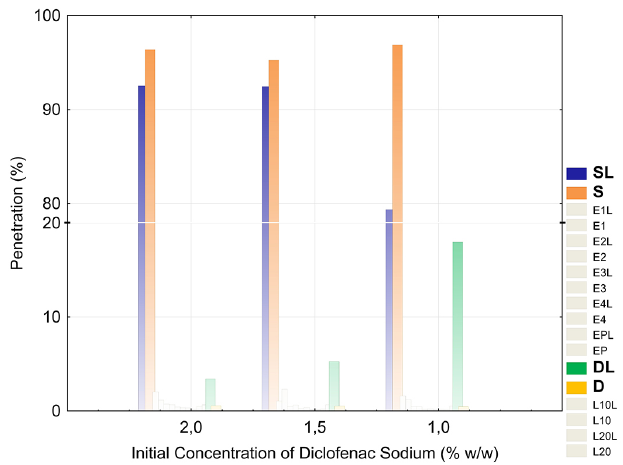
FIGURE 2 - Comparative performance of samples submitted to the laser treatment and not submitted to laser treatment. Notes: SL = Swab with laser; S = Swab without laser; E1L = tape strip 1 to 5 with laser; E1 = tape strip 1 to 5 without laser; E2L = tape strip 6 to 10 with laser; E2 = tape strip 6 to 10 without laser; E3L = tape strip 11 to 15 with laser; E3 = tape strip 11 to 15 without laser; E4L = tape strip 16 to 20 with laser; E4 = tape strip 16 to 20 without laser; EPL= epidermis with laser; EP= epidermis without laser; DL= Dermis with laser; D= Dermis without laser; L10L= receptor liquid 10 min with laser; L10= receptor liquid 10 min without laser, L20L= receptor liquid 20 min with laser; L20= receptor liquid 20 min without